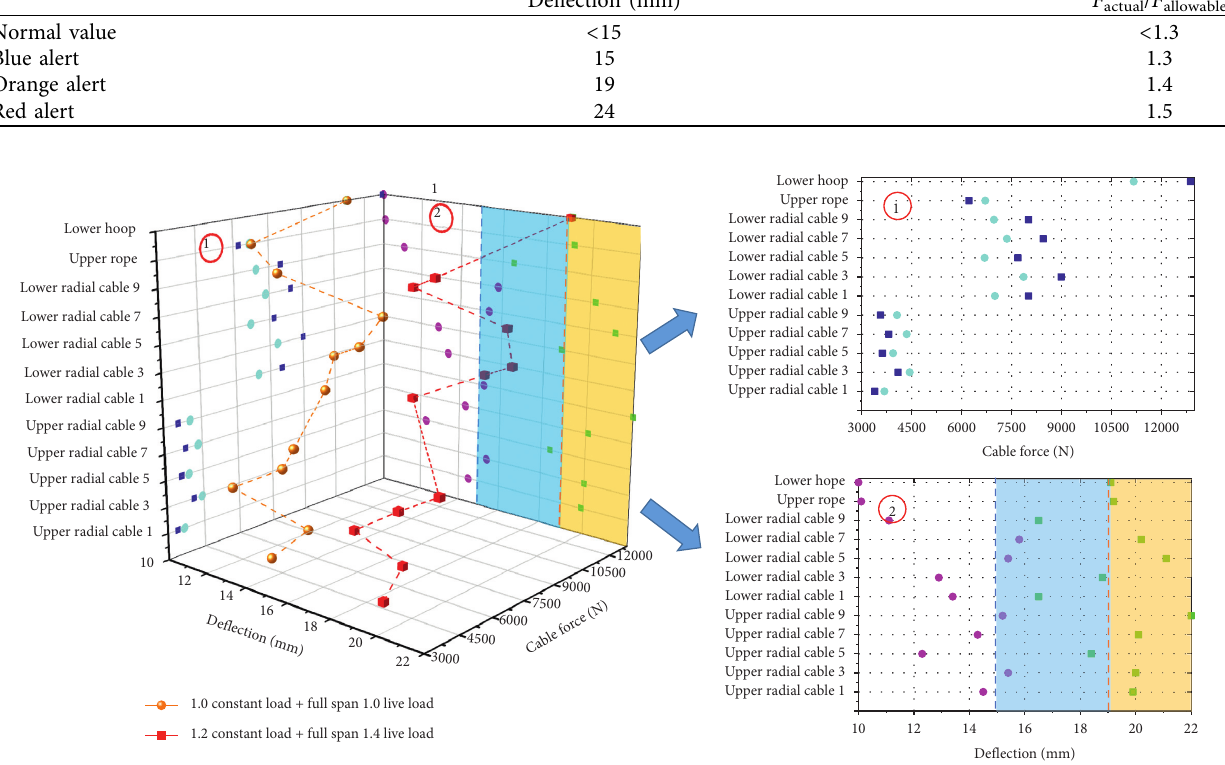
Figure 10: Physical test results under two working conditions.